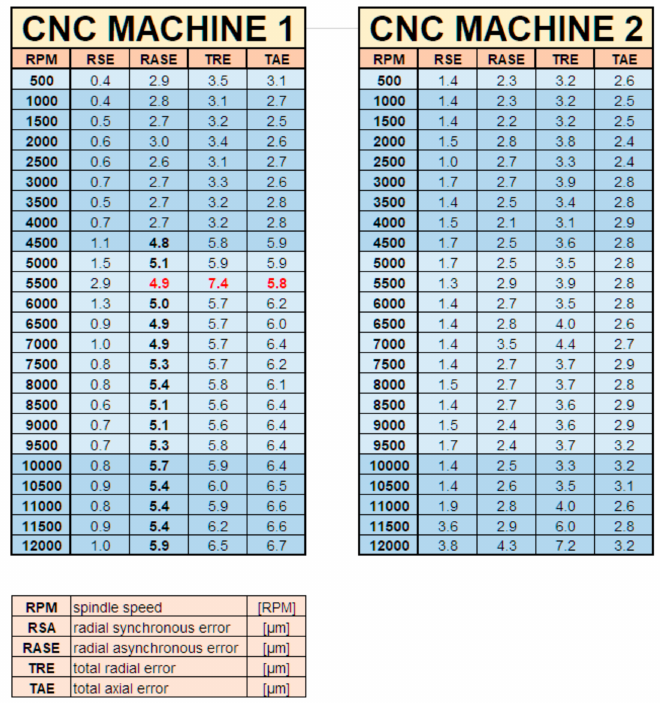
Figure 74. Comparison of the test results of two